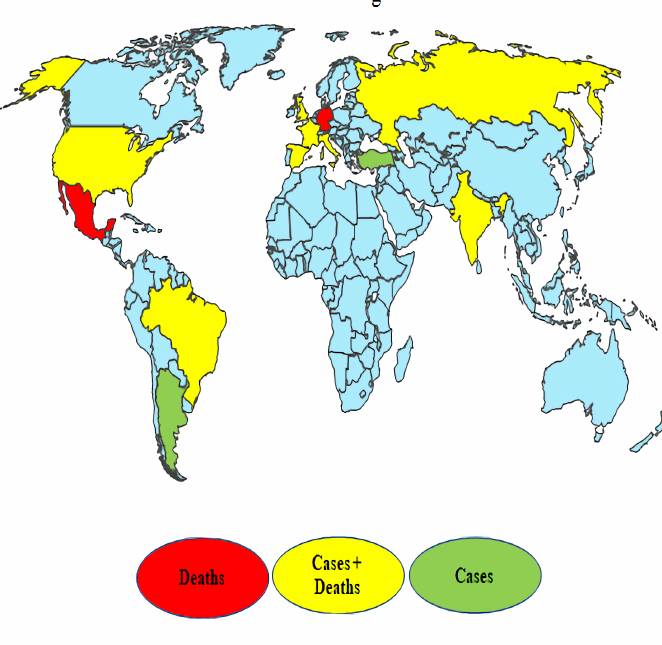
Figure 4. Political map showing the distribution of more than 60% of morbidi- ties and mortalities around the